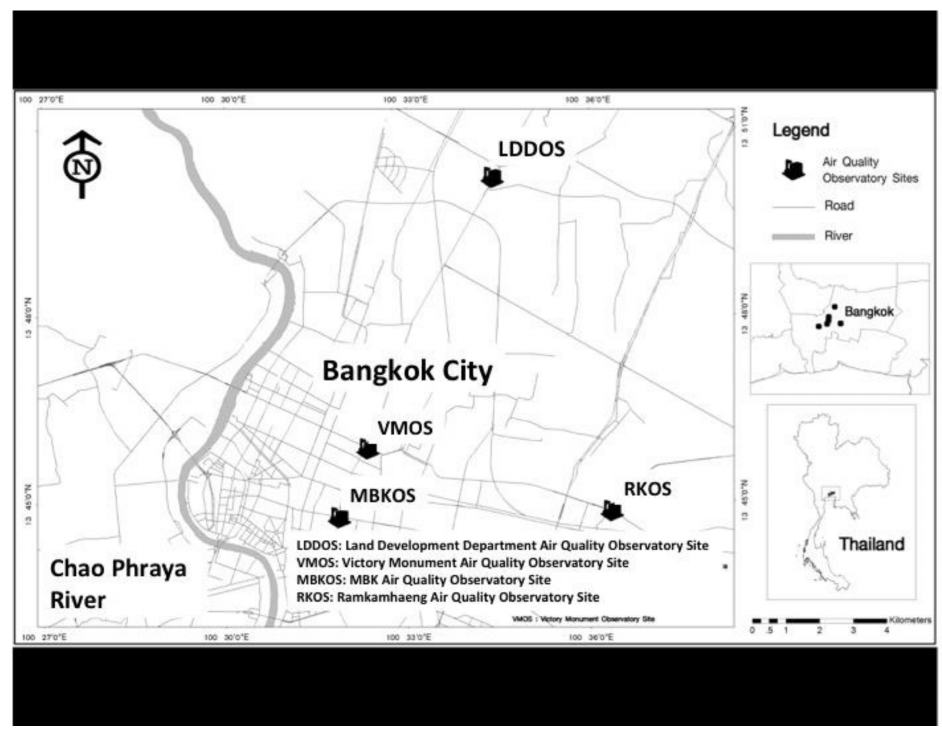
Figure 1. Locations of four PCD air quality observation sites,